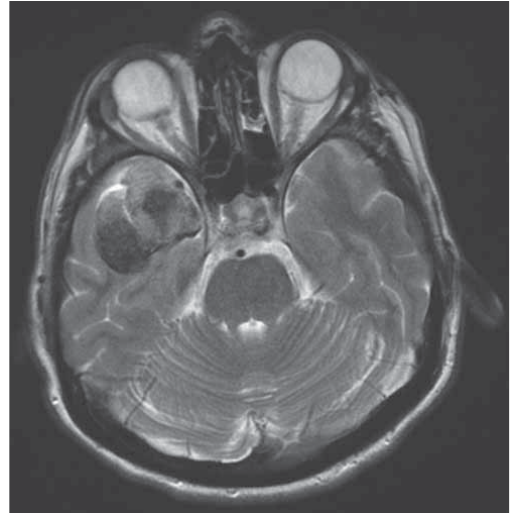
FIGURE 3. Brain T1-weighted MRI of dermoid cyst. FIGURE 4. Brain T2-weighted MRI of dermoid